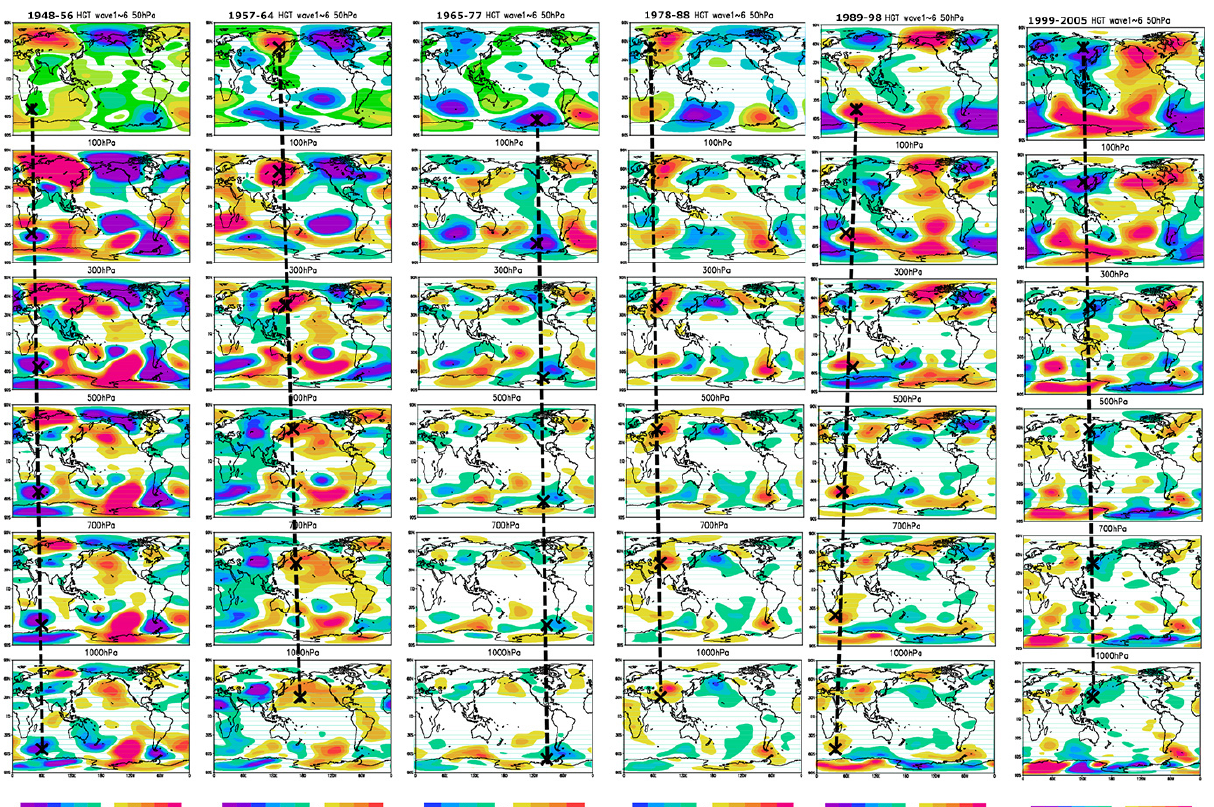
Figure 6. Reconstructed global wave amplitude anomalies from the height fields for planetary wavenumbers 1–6 with altitude (pressure level). The vertical panels arranged from left to right are the periods in 1948–1956; 1957–1964; 1965–1977; 1978–1988; 1989–1998; and 1999–2005, respectively (negative anomalies: blue–purple shading; positive anomalies: green–yellow–red). The vertical dashed line and “ × ” give an example during each decadal period representing the connection of the planetary wave active centers between stratosphere, troposphere and Earth’s surface